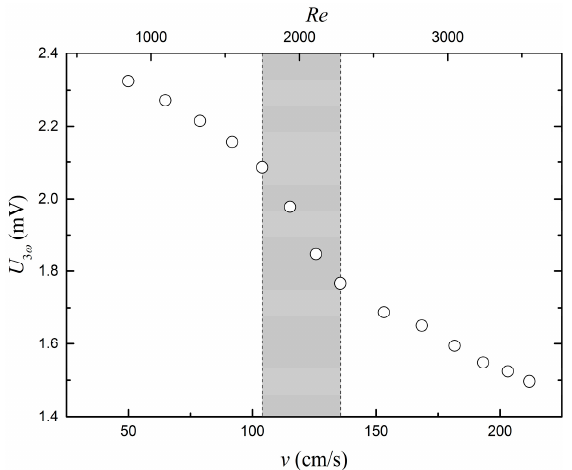
Figure 10 . Amplitude of the 3 ω signal as a function of the linear flow speed of the water in contact with the sensor. The upper x -axis shows the Reynolds numbers corresponding to the flow speeds. The standard deviations of the data are smaller than the data points on the graph.